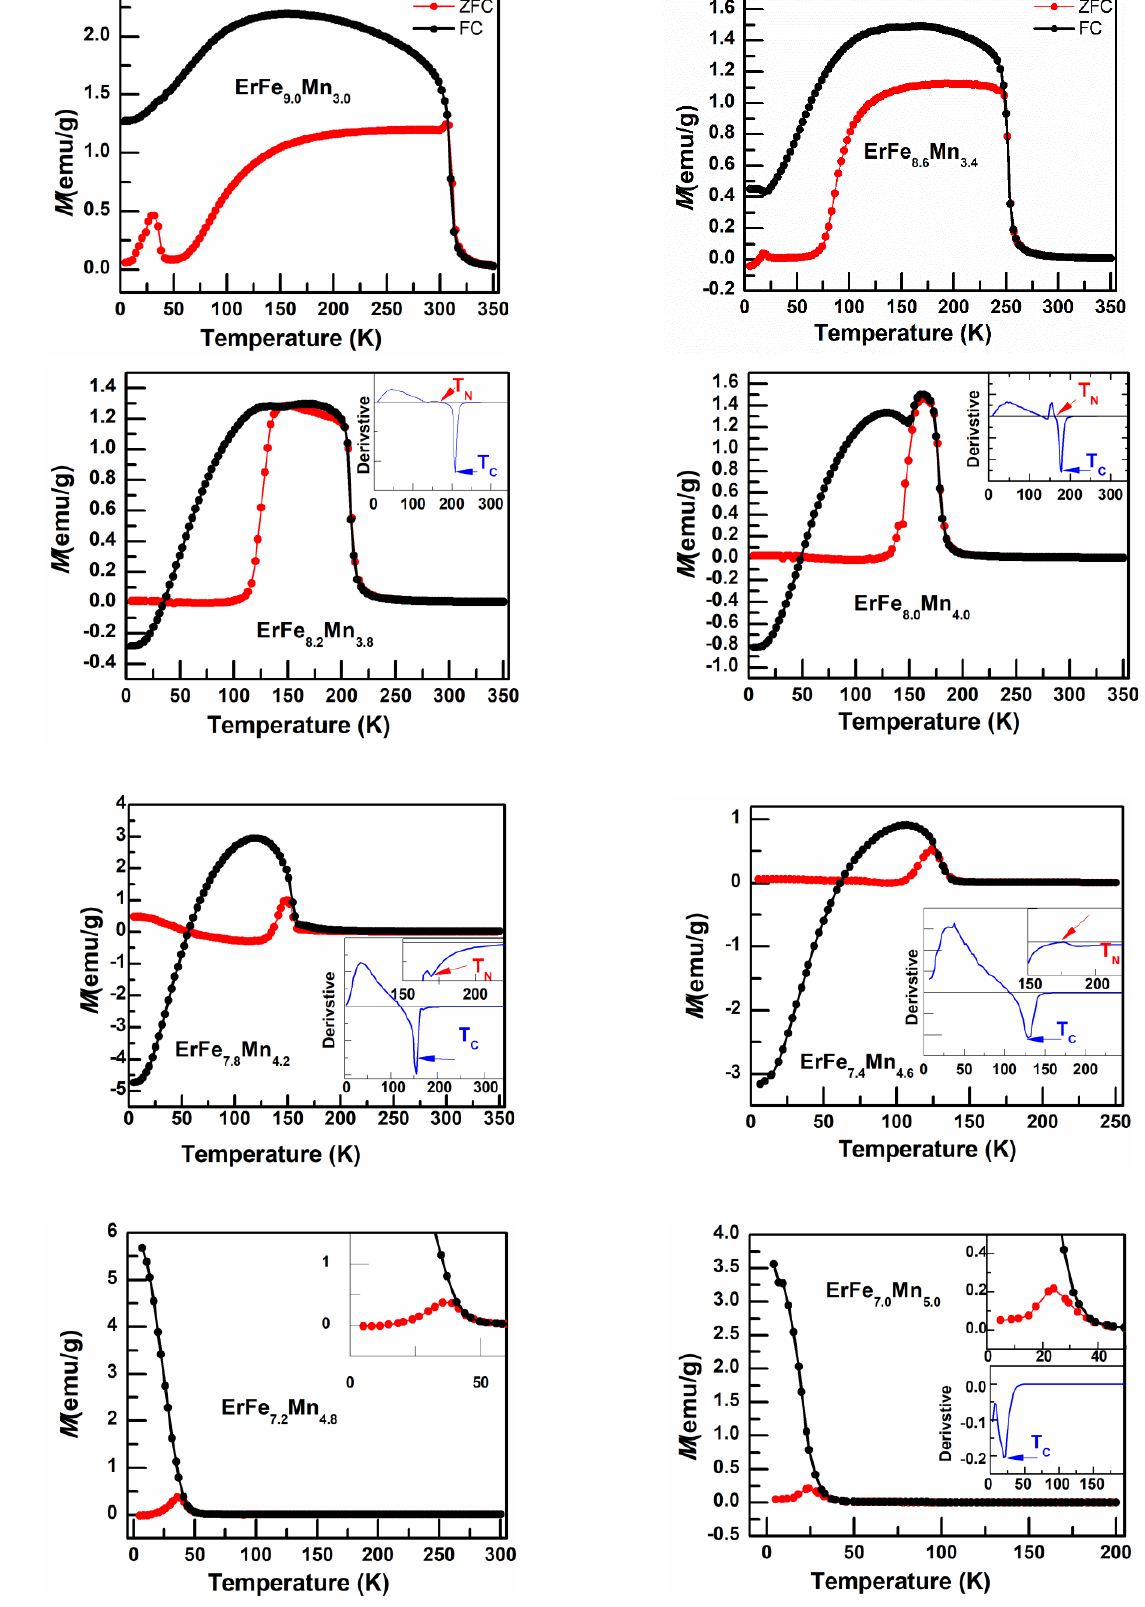
Figure 3. M − T curves for ErFe x Mn 12 − x (7.0 ≤ x ≤ 9.0) series alloys under zero field cooling (ZFC) and field cooling (FC) conditions, H = 50 Oe. (The inset shows the M − T curves under FC after